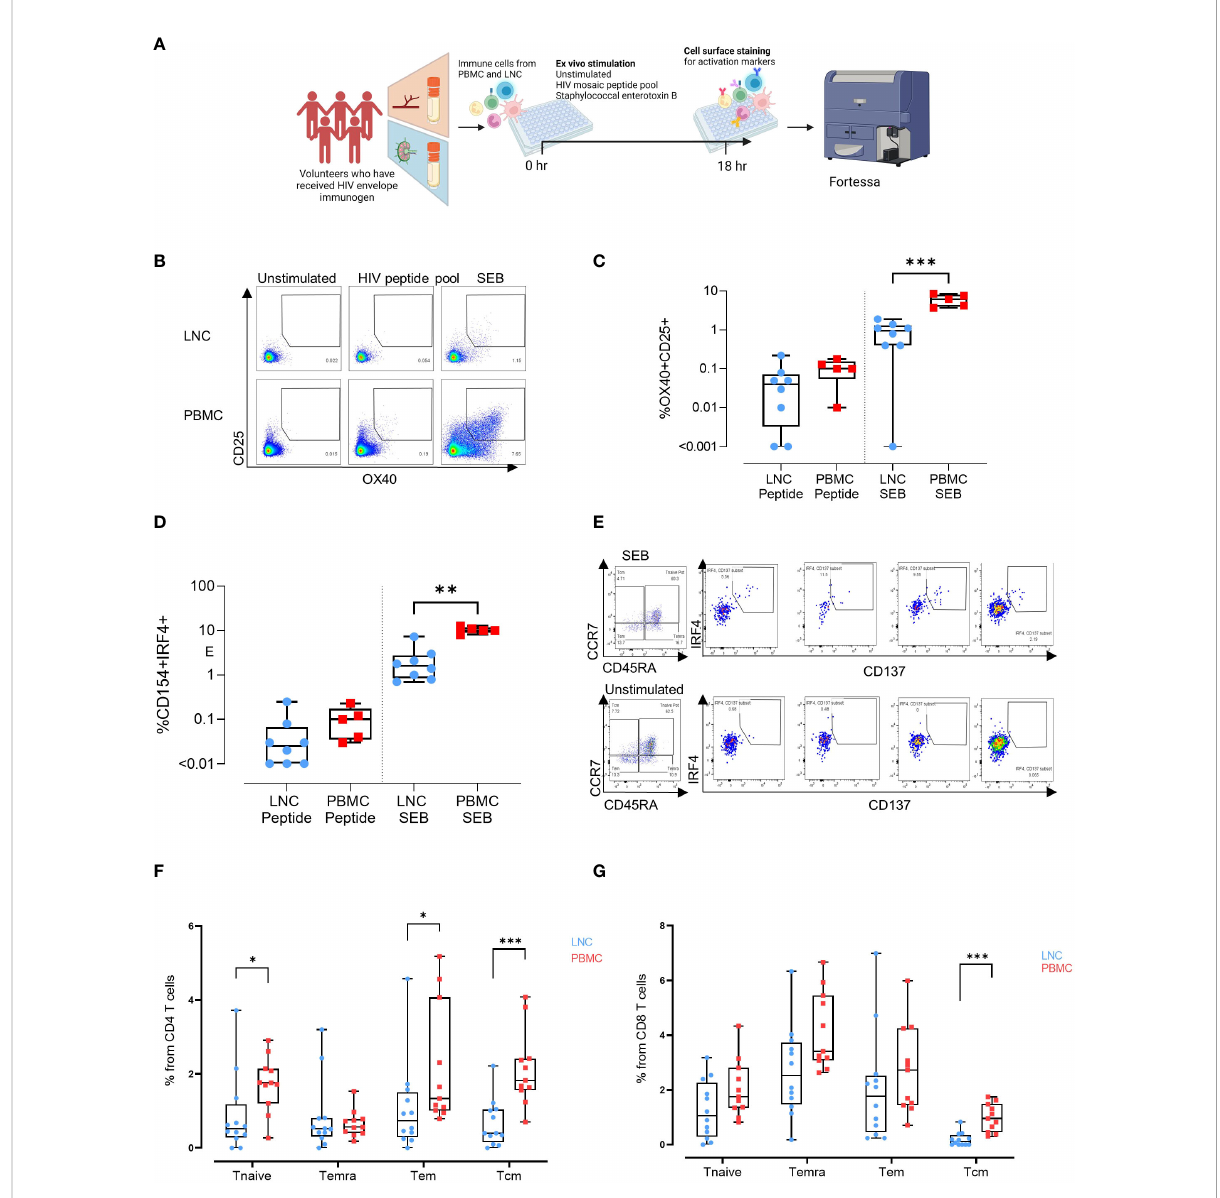
FIGURE 5 Induction of HIV-speci fi c CD4+ T cells in lymph node and blunting of the superantigen response compared with the blood. (A) Stimulation experiments: Activation induced marker assay (B) Representative gating strategy for activation induced marker (AIM) assay. Cells were left unstimulated (left panel) or stimulated for 18 hours with a peptide pool covering the full length of the HIV Mosaic envelope trimers used in the immunogen injection (middle panel) or with staphylococcal enterotoxin B (right panel). Expression of CD25 and OX40 in CD4 T cells in LNC (top row) and PBMC (bottom row) is shown. (C) Box and whisker plot showing all points, lower quartile, median and upper quartile values for the LNC and PBMC stimulated with HIV MOSAIC peptide pool (left) or SEB (right) in the activation induced marker assay. Frequency of OX40 +CD25+ cells in CD4+ T cells is shown (D) Box and whisker plot showing all points, lower quartile, median and upper quartile values for the LNC and PBMC stimulated with HIV MOSAIC peptide pool (left) or SEB (right) in the activation induced marker assay. Frequency of CD154+IRF4 + cells in CD4+ T cells is shown (E) Representative gating strategy for stimulation of LNC using SEB. CD8+ T cells are shown with panels from left to right showing Temra, Tcm, Tem and Tnaive subsets. (F) Comparison of activation status of T cell memory subpopulation in PBMC and LNC after stimulation with staphylococcal enterotoxin B PBMC and LNC were cultured with SEB for 18hrs in the IRF4 assay; n=6 for right FNA, n=6 for left FNA and n=11 for PBMC. Background signals were subtracted as follows: the signal in the antigen-stimulation minus the signal in the unstimulated condition. Frequencies shown are the percentage from the parent (CD4 or CD8) population. Frequencies of CD154+IRF4+ among CD4+T cells that are naïve (CD45RA+CCR7+), Temra (CD45RA+CCR7-), Tem (CD45RA-CCR7-) and Tcm (CD45RA-CCR7+) in LNC (blue circles), and from PBMC (red squares). (G) Frequency of CD137+ IRF4+ memory subpopulation in CD8+ T cells from the LNC (blue circles) and from PBMC (red squares). The results of Mann-Whitney U tests are shown with *p<0.05, **p<0.01,